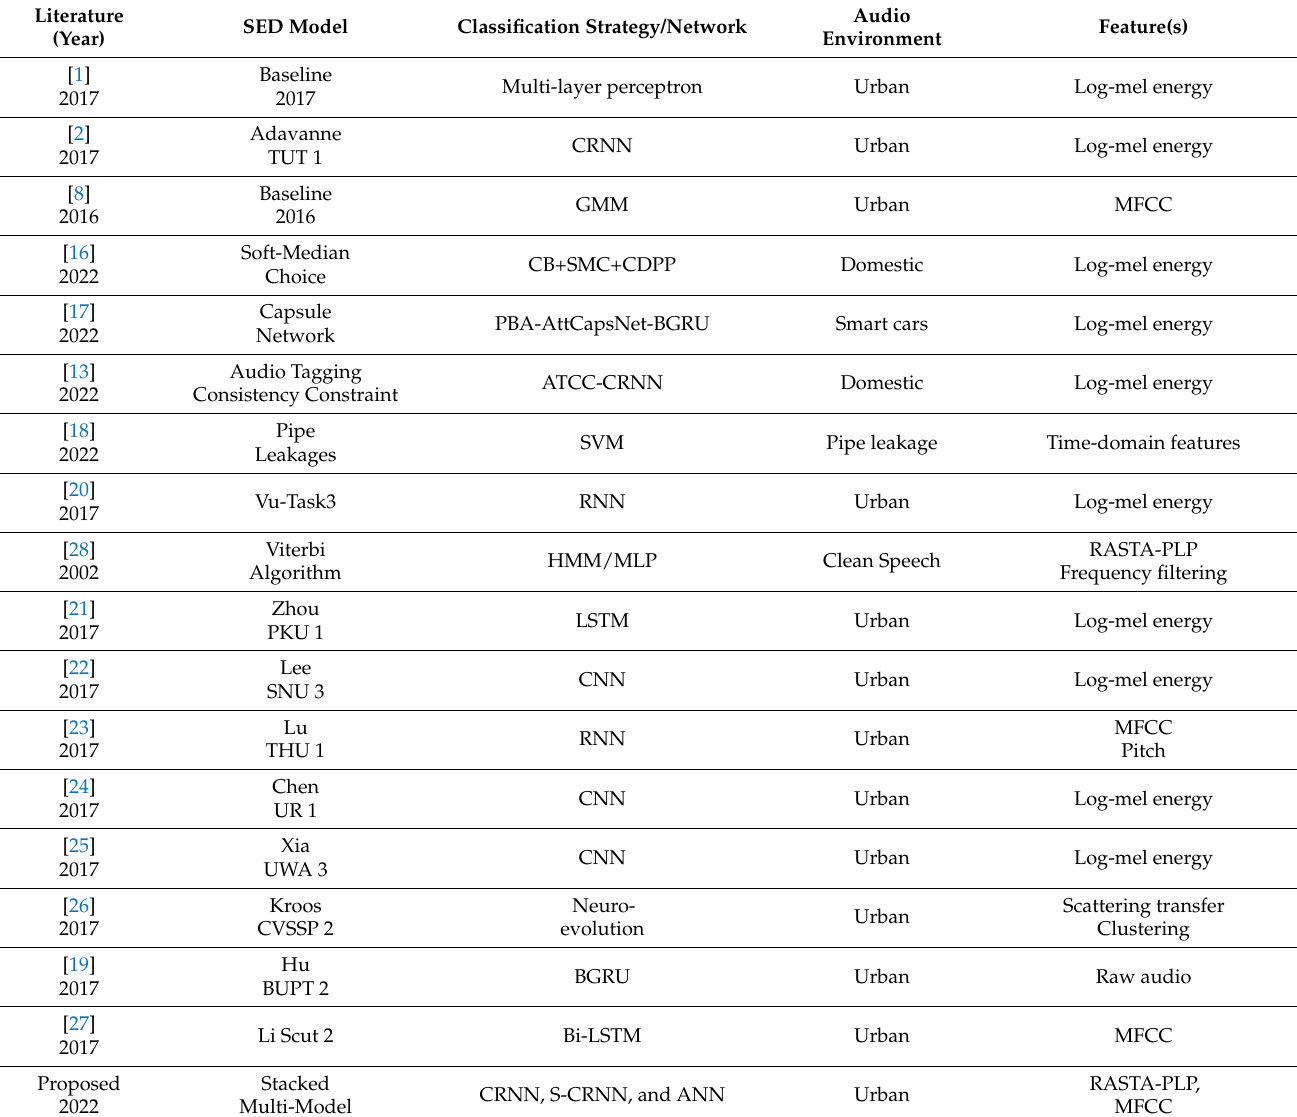
Table 1. Summary and comparison of related works on SED